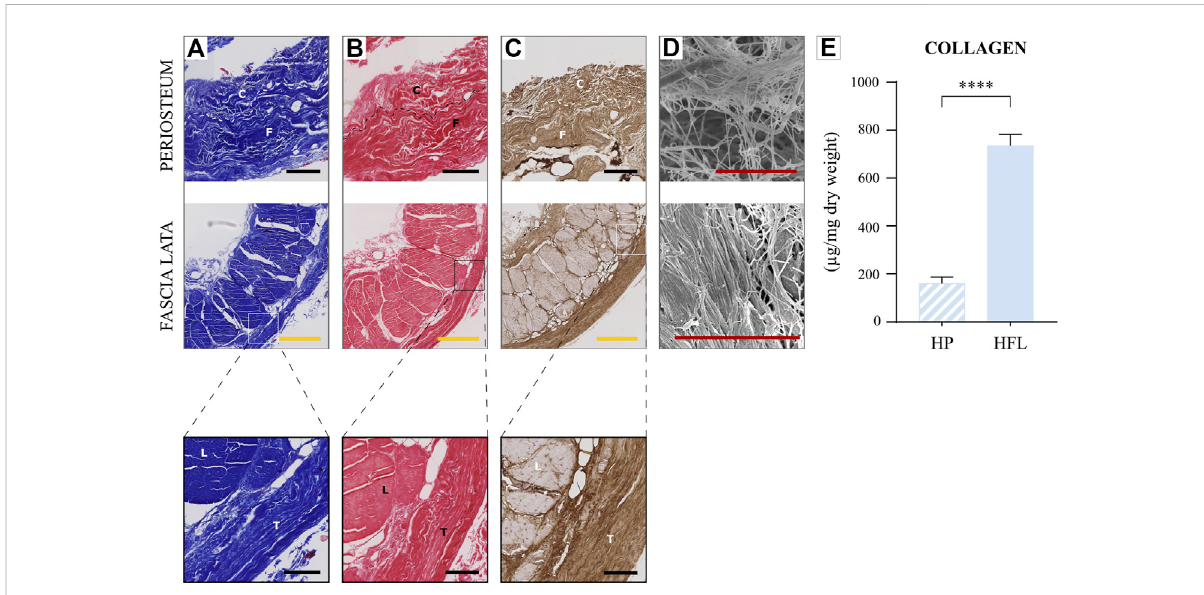
FIGURE 3 Comparison of HP (top) and HFL (bottom including zoom in) by Masson ’ s trichrome staining (A) , Sirius red staining (B) , immunohistochemistry for Type 1 collagen (C) , electron microscopy (D) and collagen quanti fi cation (N = 4 donors × three samples from each donor leading to n = 12 specimens analyzed for each tissue) (E) . C: cambial layer, F: fi brous layer, L: longitudinal layer, T: transverse layer, HP: human periosteum, HFL: human fascia lata. Black scale bars: 100 µm. Yellow scale bars: 500 µm. Red scale bars: 5 µm. **** p <